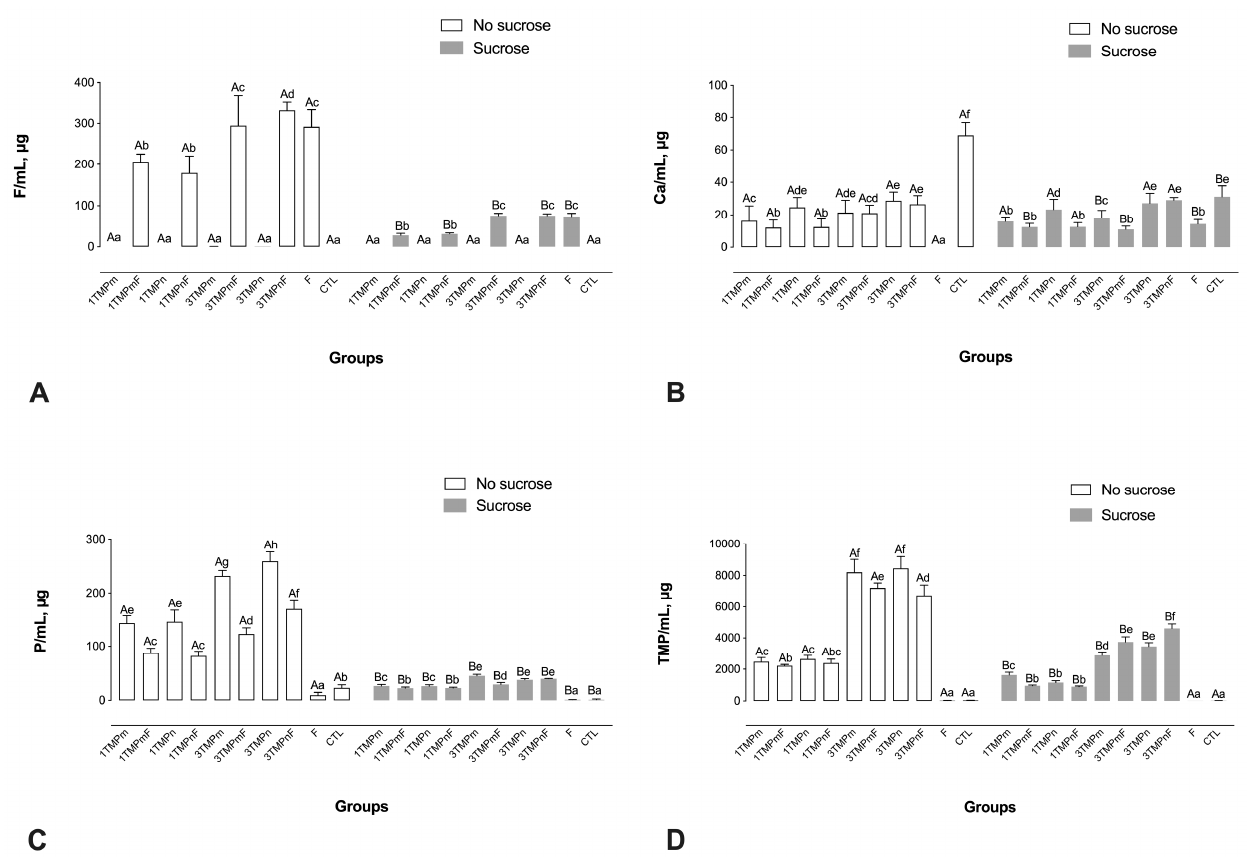
Figure 2. Mean values of F ( A ), Ca ( B ), P ( C ), and HMP ( D ) in the biofilm fluid, prior to and after exposure to sucrose (cariogenic challenge). Distinct upper-case letters indicate statistical within each group regarding exposure to a 20% sucrose solution (in two levels—yes or no). Distinct lower-case letters indicate statistical differences among the experimental groups (all test solutions) within each condition of sucrose exposure). Data were submitted to 2-way ANOVA, followed by Fisher LSD’s post hoc test for multiple comparisons ( p < 0.05). Bars denote standard deviations of the means. The experiments were performed in triplicate, in three different moments ( n = 9). Ca: calcium; F: fluoride; P: phosphorus; TMPm: micro-sized sodium trimetaphosphate; TMPn: nano-sized sodium trimetaphosphate; CTL: negative control.